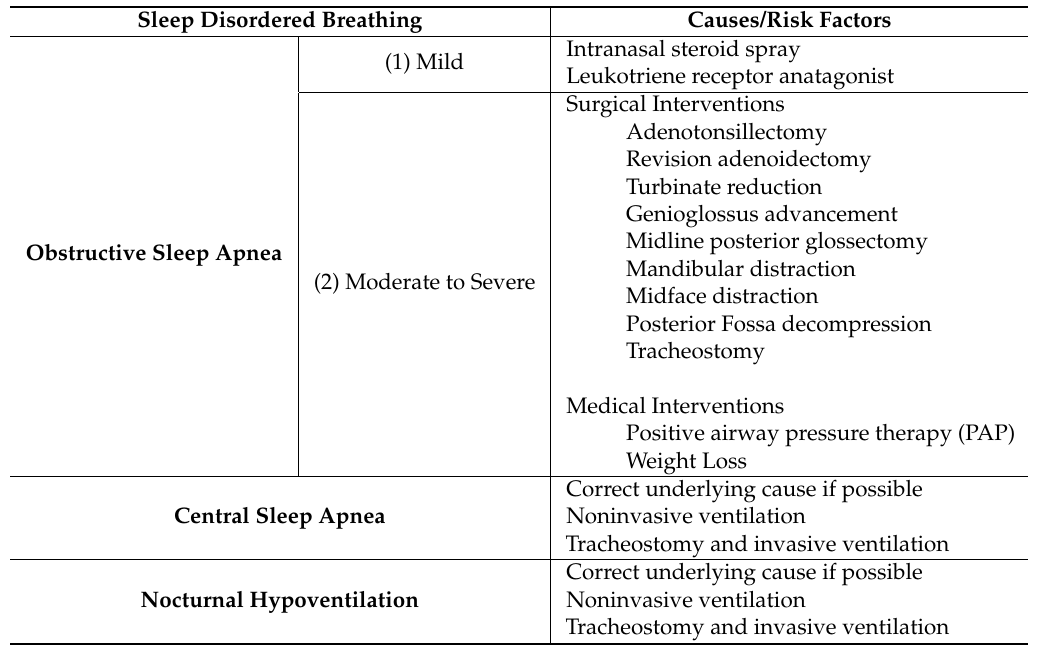
Table 2. Treatment options for